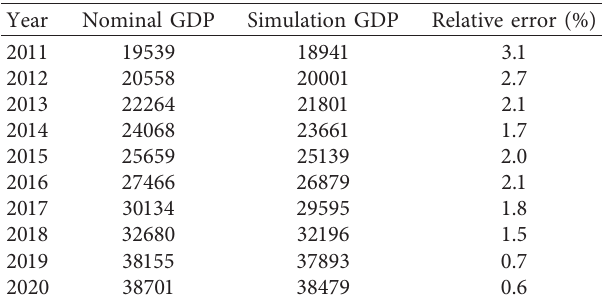
Table 5: Comparison of simulation results and actual results of port